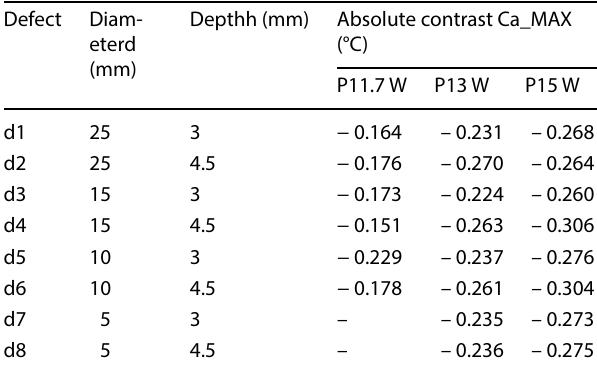
Table 6 Numerical absolute contrast for the SMArt thermography applying increased power Defect